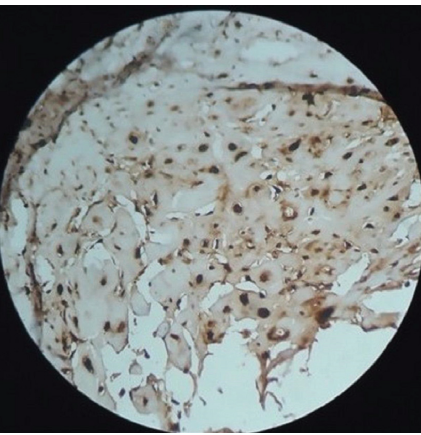
Figure 6: Immunostaining showing positivity for S100 (H&E, 10x).